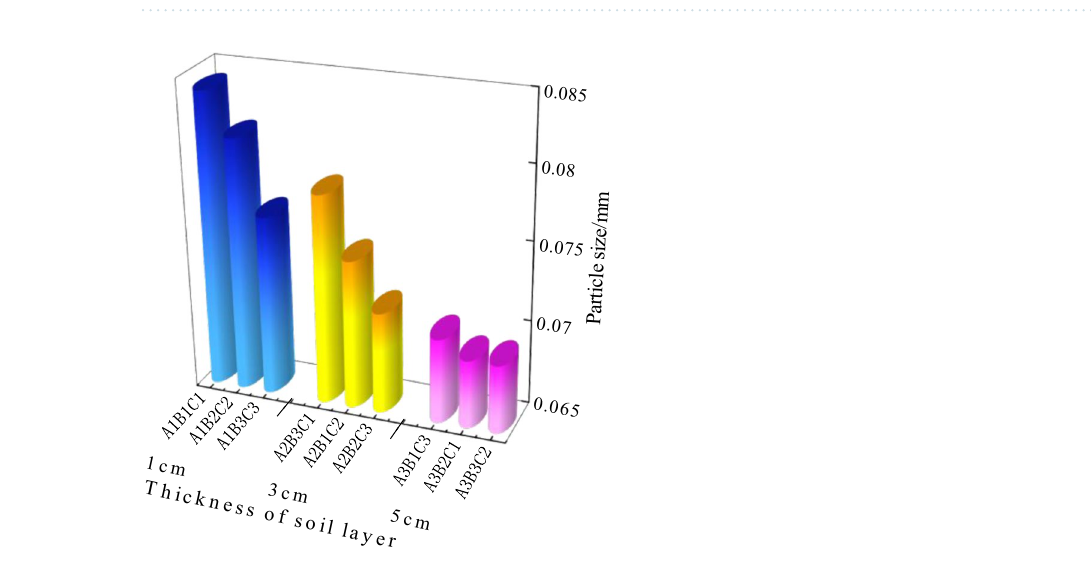
Figure 16. Graph of particle size versus surface strength.